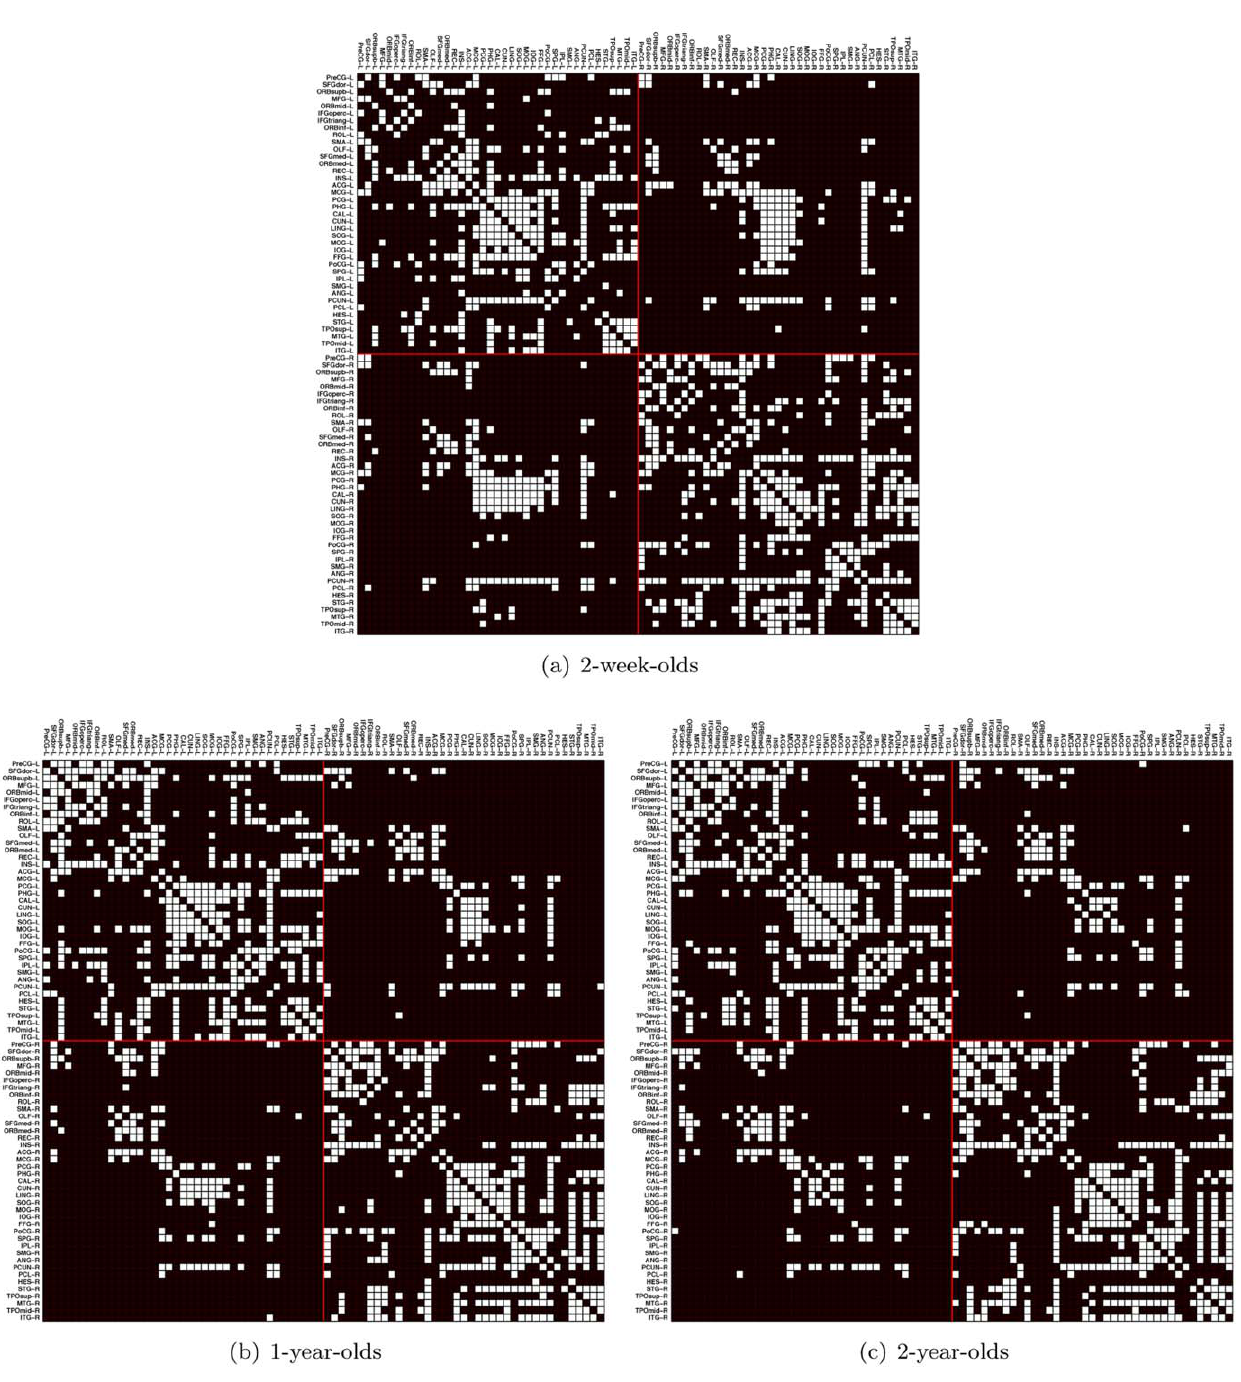
Figure 2. Connectograms. Connectivity matrices characterizing the backbone connections. The network cost is 0.21, which ensures that all nodes were full connected (see Fig. 3).